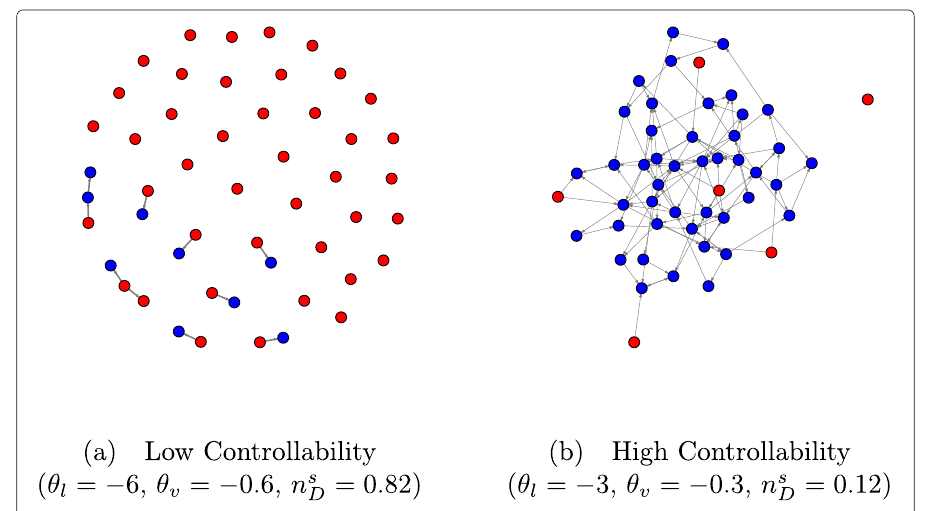
Fig. 2 Controllability of Random Networks. These visualizations highlight how small changes in ERGM coefficients can have large effects on the controllability of a network, driven primarily by changes in link frequency. In each network ( a ) and ( b ), a randomly selected minimum driver set is highlighted in